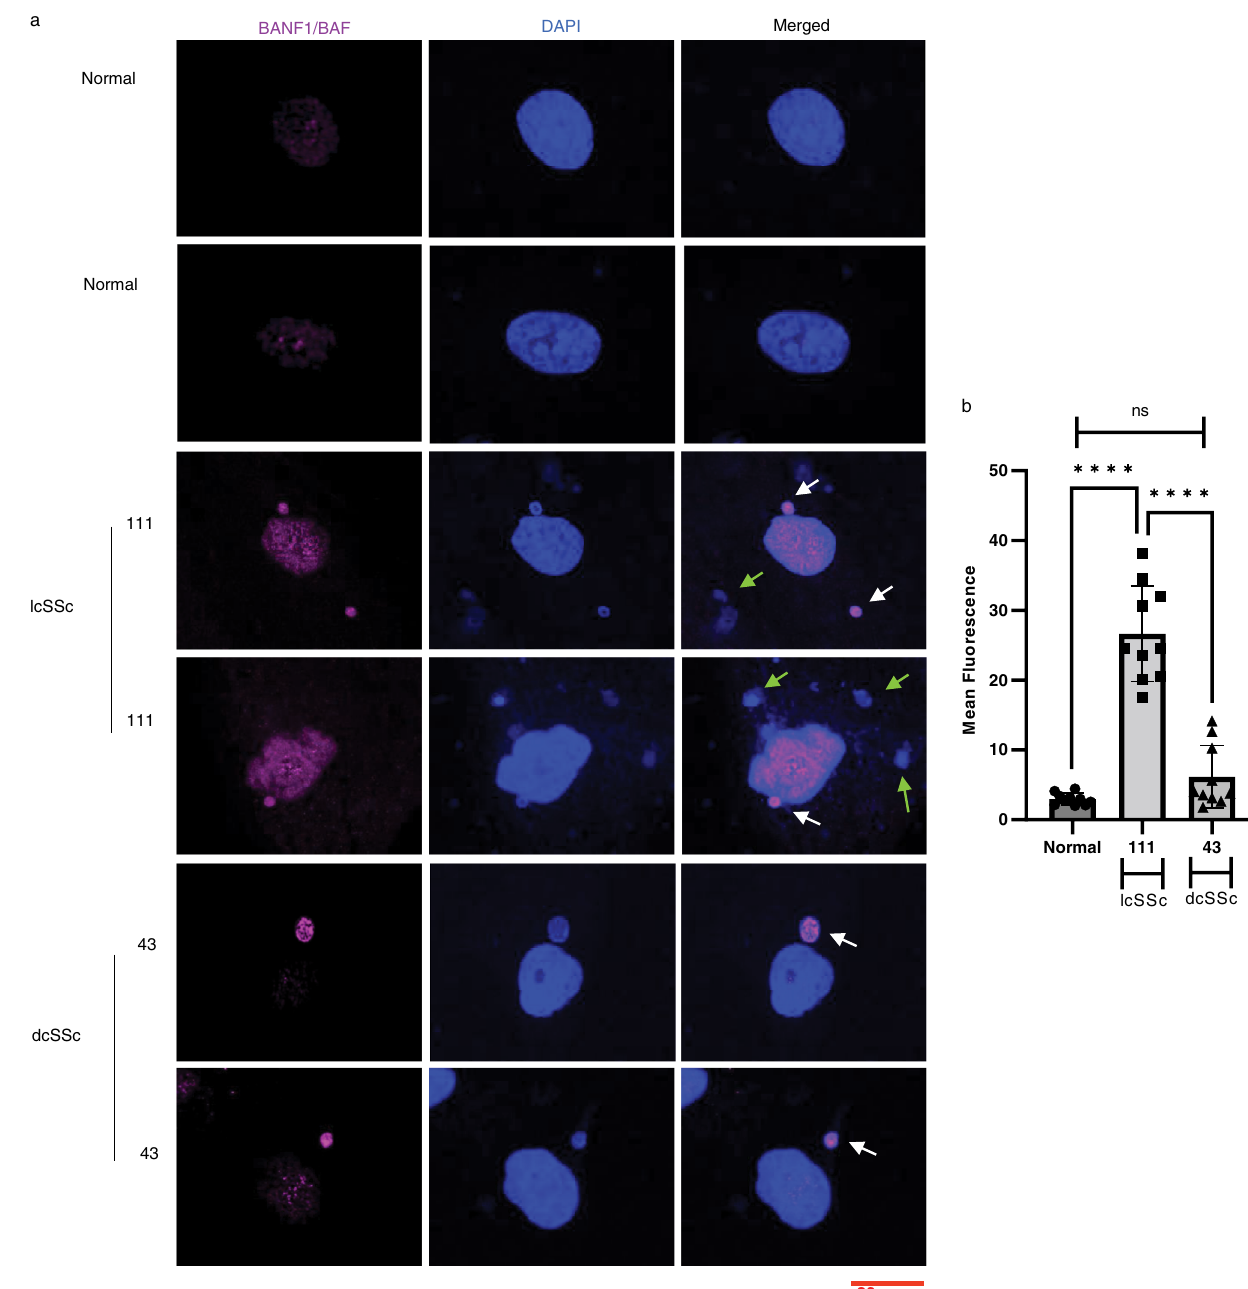
Fig. 4 | Nuclei and micronuclei membrane integrity in SSc fi broblasts. a We performed IF to visualize the expression of BANF1/BAF (purple), a marker for nuclear membrane integrity, in SSc skin fi broblasts. Nuclei and micronuclei were counterstained with DAPI (blue). In contrast to healthy and dcSSc skin fi broblasts (patient 43), abnormal expression of BANF1/BAF was found in the nuclei of the fi broblasts from an lcSSc patient (111) with centromere protein leaking suggesting nuclearmembranedisruption.Themicrographsalsoshowthatthe fi broblastsfrom